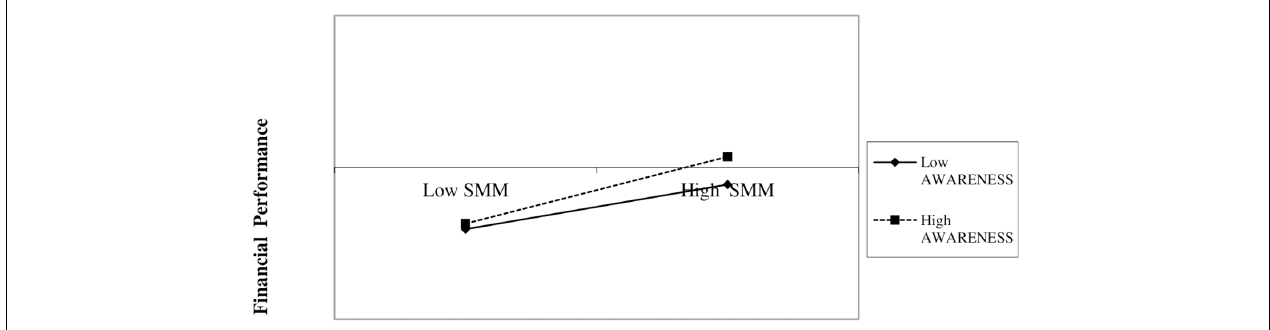
FIGURE 2 | Two-way interaction. SMM * AWARENESS. SSM, social media marketing, how intensely the company implements Social Media Marketing actions; AWARENESS, brand awareness, as the goal of the